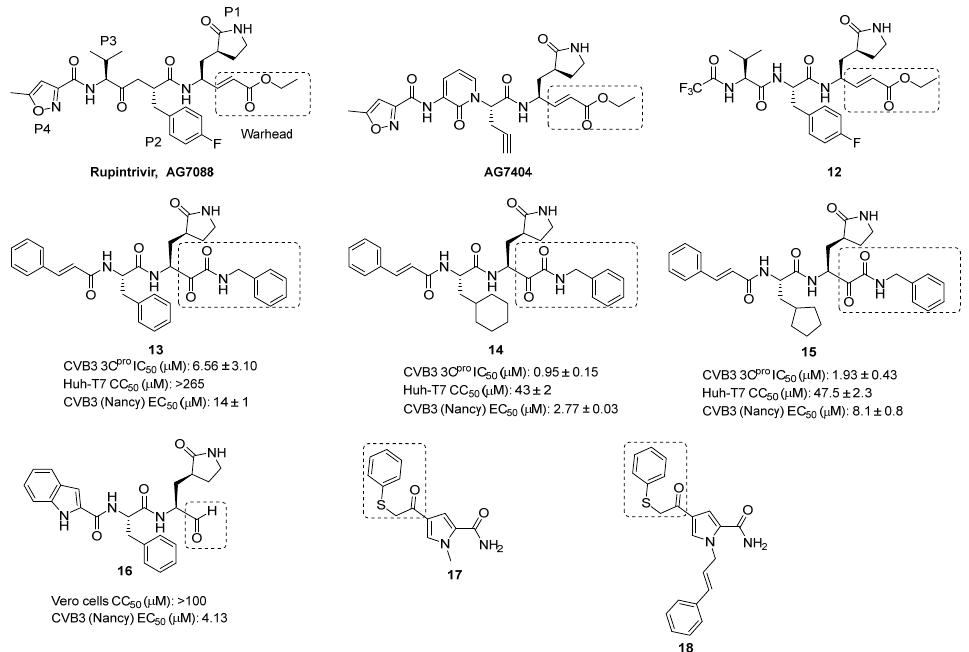
Figure 9. Chemical structures of rupintrivir, AG7404 and compounds 12 – 18 and biological activities of compounds 13 – 16 . Highlighted in the boxes are the main chemical motifs responsible for the interaction with protein 3C.